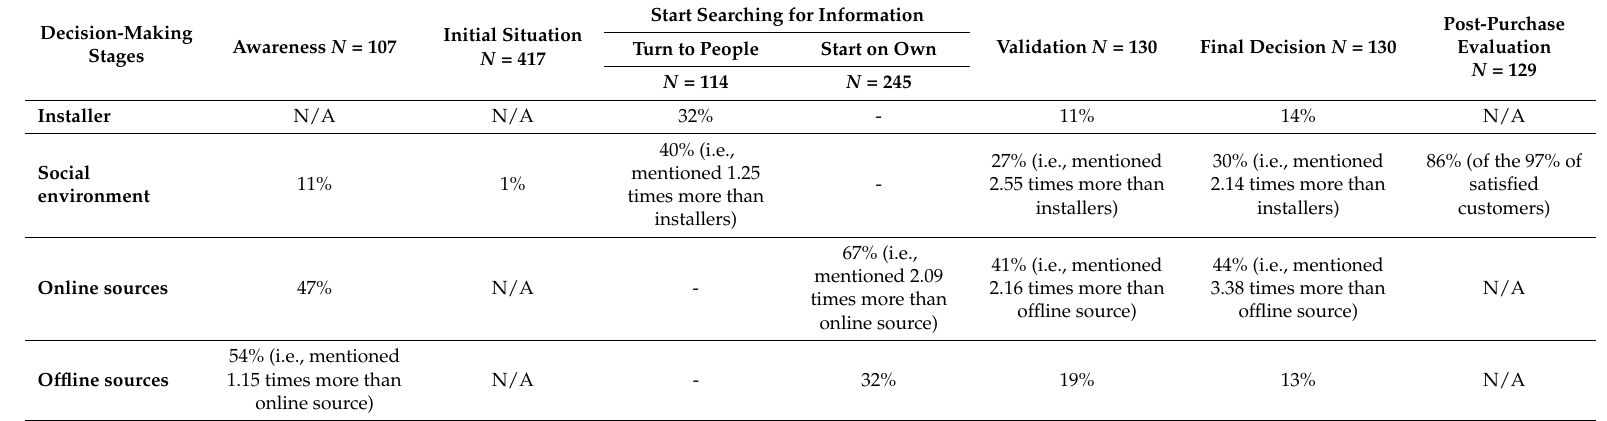
Table 3. Summary of results: relative frequencies and the role of the social influence in the